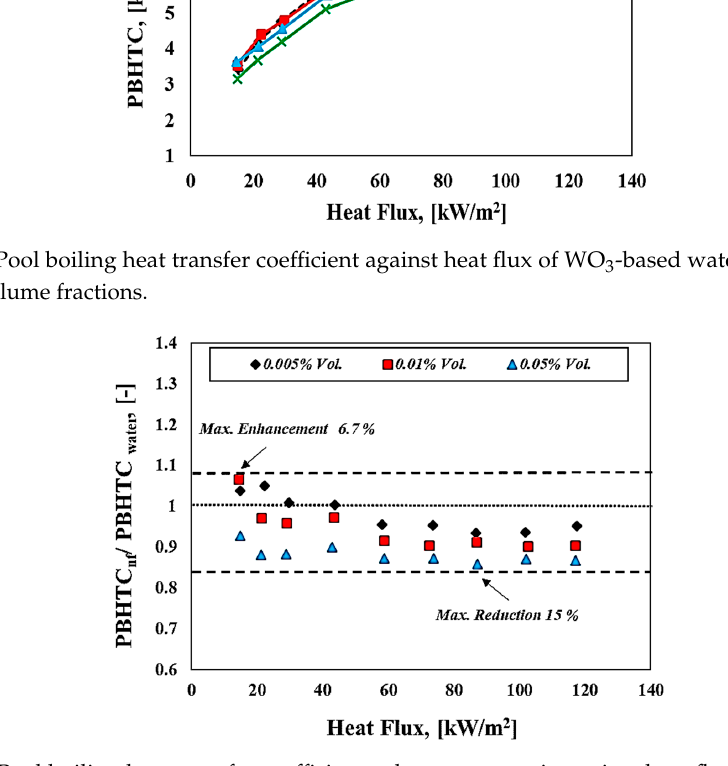
Figure 11. Pool boiling heat transfer coefficient enhancement ratio against heat flux of WO 3 -based water nanofluids at different volume fractions.